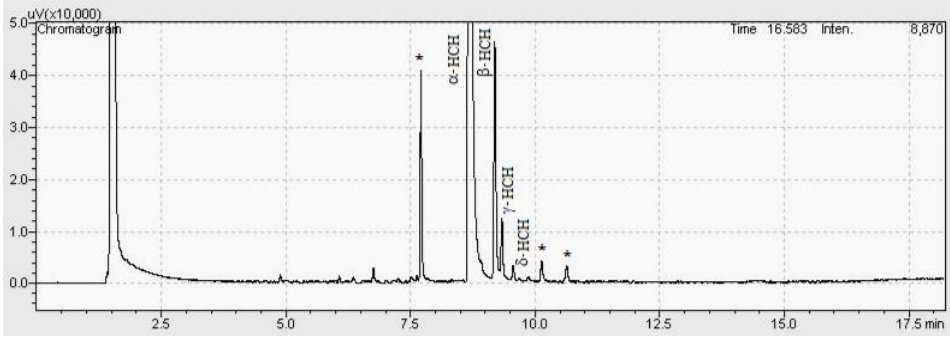
Int. J. Environ. Res. Public Health 2020 , 17 , x Figure 5. Chromatogram of the sample n1. Asterisks indicate some non-identified compounds.